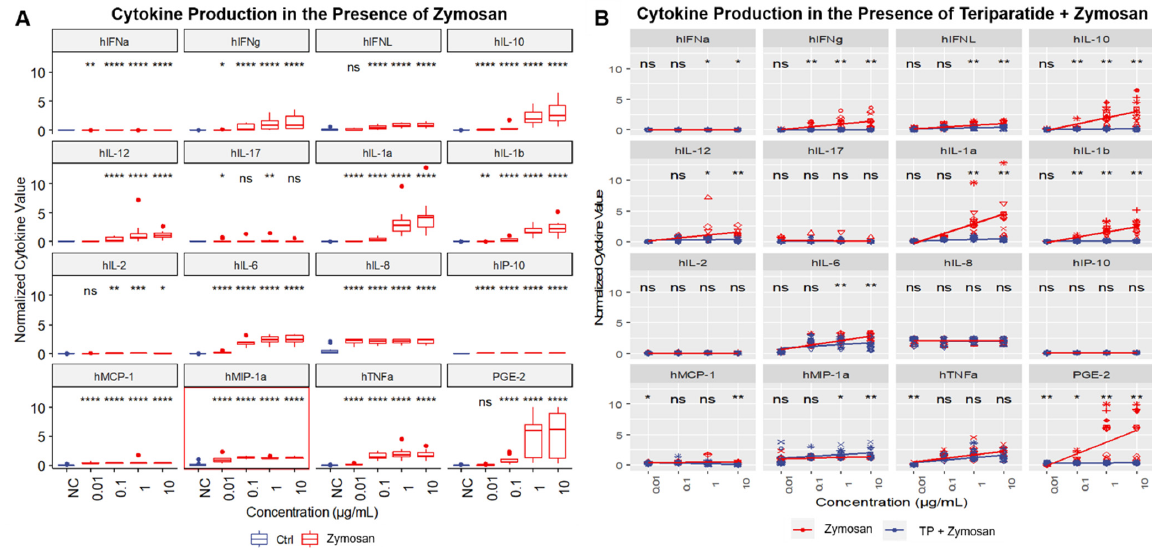
Figure 3. Normalized Cytokine Response to Zymosan and/or Teriparatide and Selection of One Signature Cytokine: PBMCs from 10 healthy human donors were treated with ( A ) zymosan alone or ( B ) zymosan in combination with 25 µ g/mL TP for 24 h. Supernatants were analyzed for the presence of cytokines by multiplex ELISA. The signature cytokine (red box) is the one for which the IIRMI concentration, when compared to the PBS negative control (NC), results in a p < 0.05. The data for which statistical significance was not observed are marked with ns. Statistical significance is shown with an asterisk as follows: * p < 0.05; ** p < 0.01; *** p < 0.001; and **** p < 0.0001. Similar results for the other nine IIRMIs are available in Figures S7 and